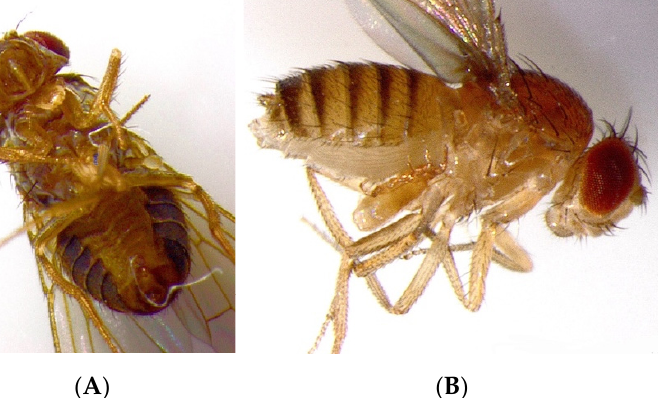
Figure 3. A female of Blattisocius mali attached to the cervix (neck) of a female of Drosophila hydei ( A ) and at the coxa III of a female of D. melanogaster ( B ).